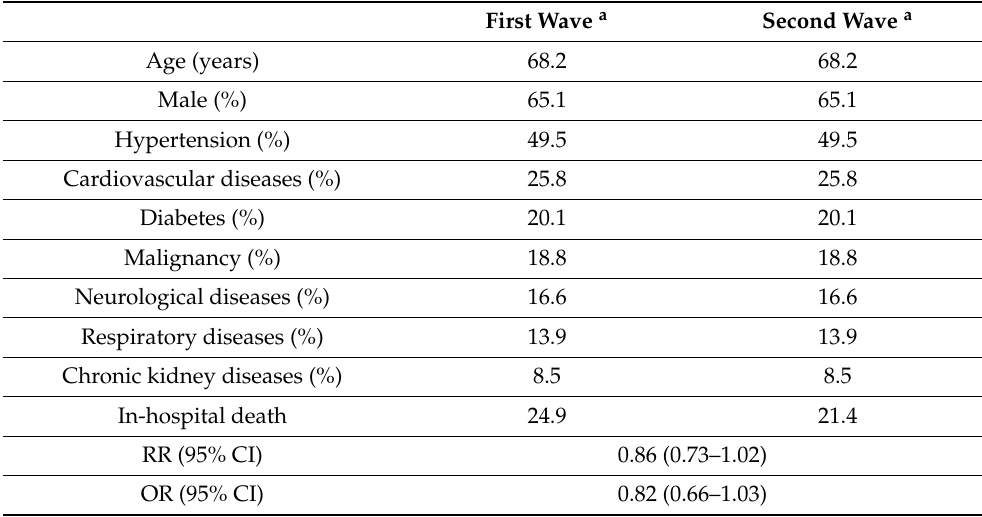
Table 2. Overlap propensity score–weighted characteristics and in-hospital death among patients hospitalized for COVID-19 during the first or the second epidemic wave. First Wave